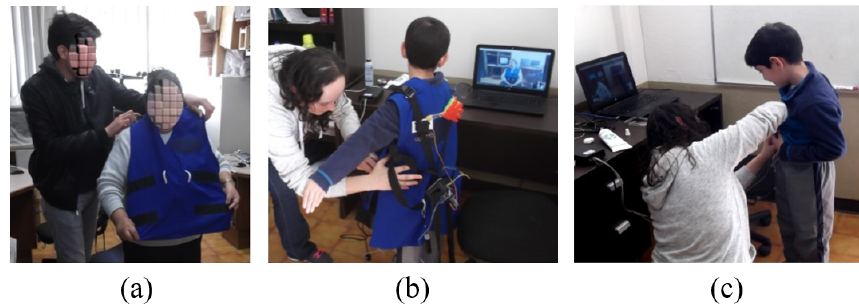
Figure 8. Participants putting on the AffectiVests: ( a ) Grandmother, ( b ) grandchild and ( c ) Putting the plethysmograph and electromyograph on the grandchildren.